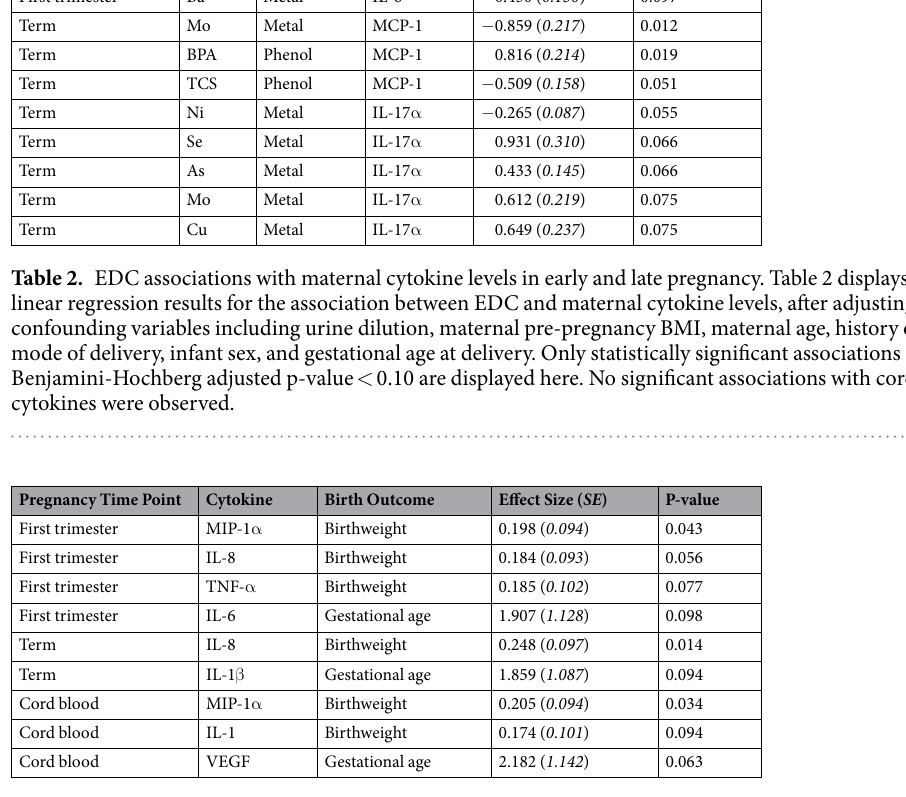
Table 3. Cytokine associations with birth outcomes. Table 3 displays linear regression results for the association between inflammatory cytokines and birth outcomes. Adjustments were made for confounding variables including urine dilution, maternal pre-pregnancy BMI, maternal age, history of smoking, mode of delivery, and infant sex. Only associations considered significant with p-value < 0.10 are displayed here. Tables 4–6 demonstrate each of the specific PC groupings which were significantly associated (p < 0.05) with maternal first trimester, maternal term, and delivery cord blood inflammation,